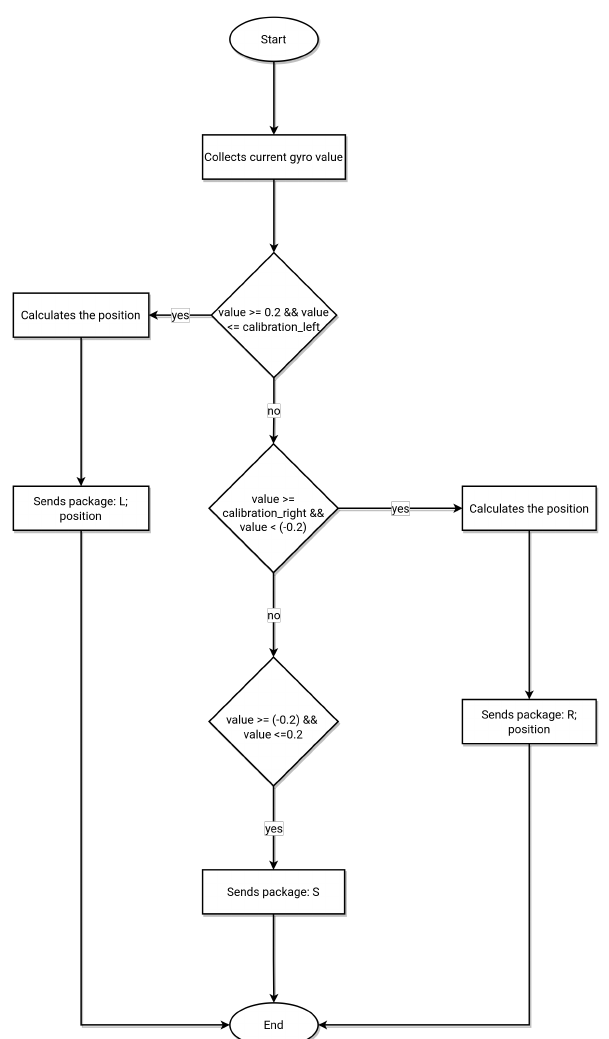
Figure 10. Flowchart of the move validation function. Source: Author